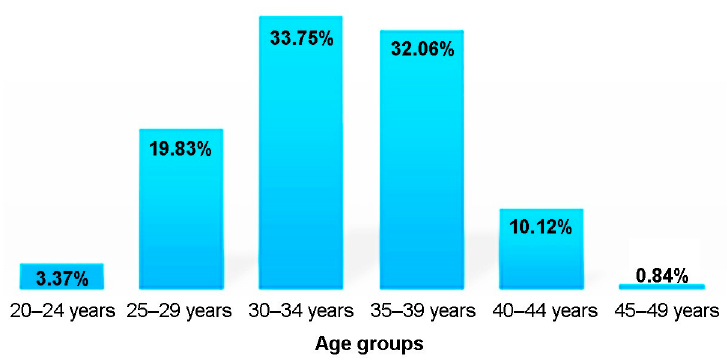
Figure 3. Distribution of cases considering maternal age.